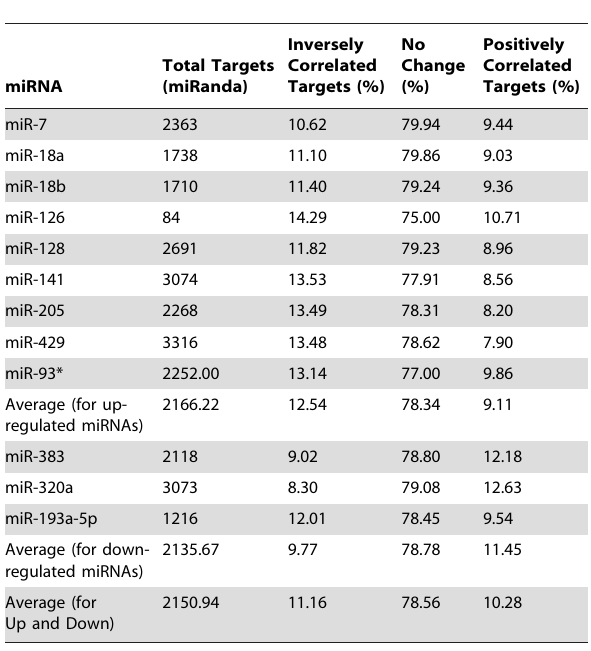
Table 2. Summary values of IC, PC and NC targets in CEPI vs. OSE using miRanda.